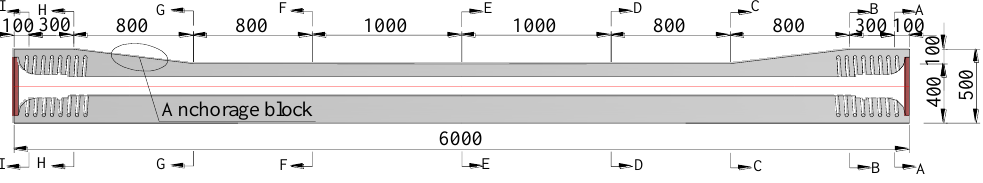
Figure 4. Global and local ANSYS models: ( a ) box girder; ( b ) top slab (1.4 m × 6 m ); and ( c ) bottom slab (1.6 m × 7 m ).